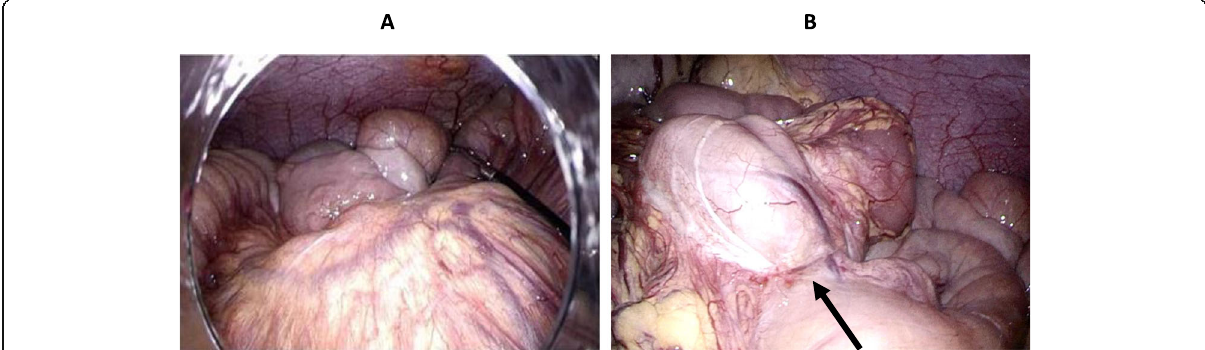
Fig. 3 Intraoperative findings. a Small bowel mesentery is congested. b Note stenosis in the small bowel (arrow)